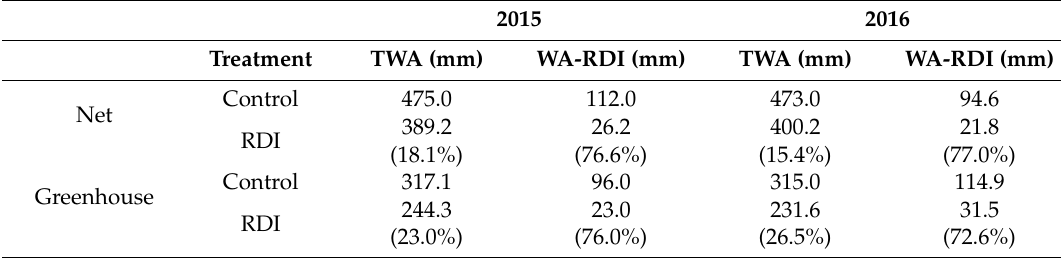
Table 2. Total water applied (TWA) throughout the season, water applied during the deficit irrigation period (WA-RDI) in both seasons and cultivation system. Between parentheses, in TWA column, annual water savings (%) in RDI plants with respect to control